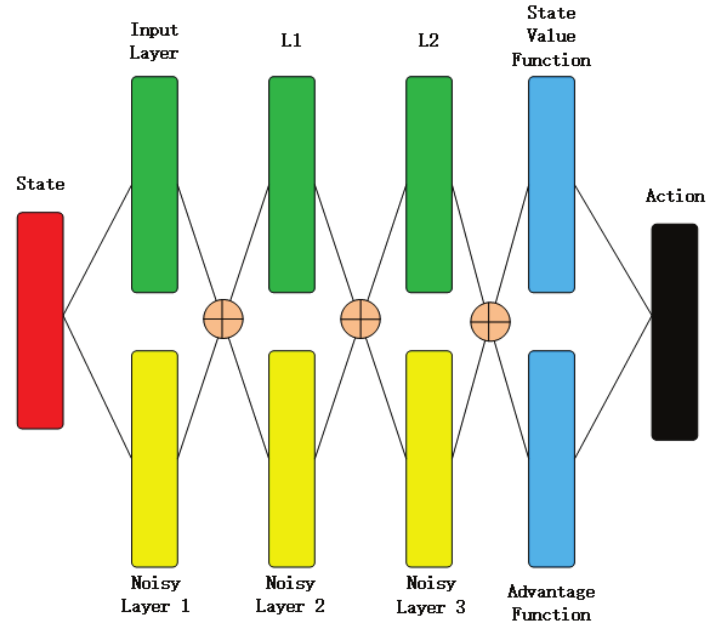
Figure 7. Neural network architecture.